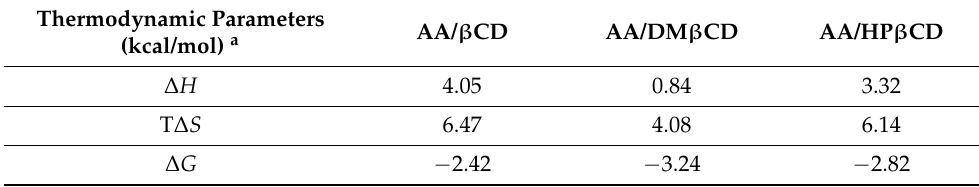
Table 2. Thermodynamic values for the inclusion complexation between AA and β CD(s). Table 1. Stability constant ( K c ) of the AA/ β CDs inclusion complexes at different temperatures. Thermodynamic Parameters Temperature (°C)